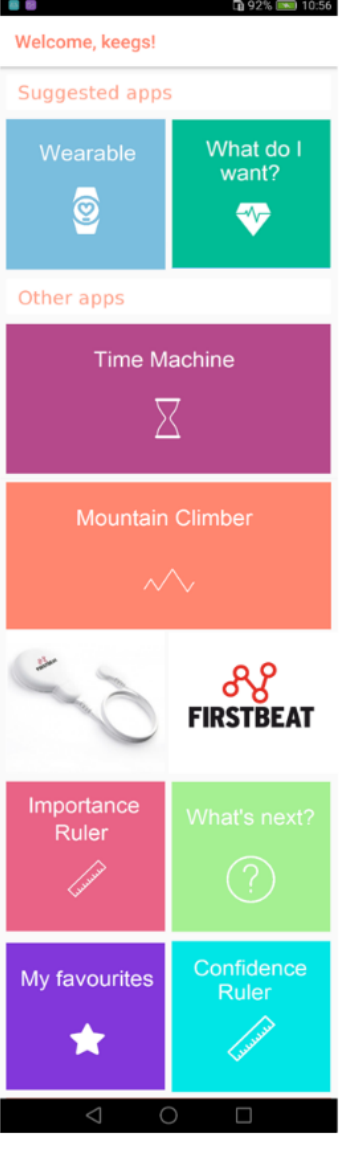
Figure 2. Implementation of the Precious app home screen, with suggested apps at the top of the